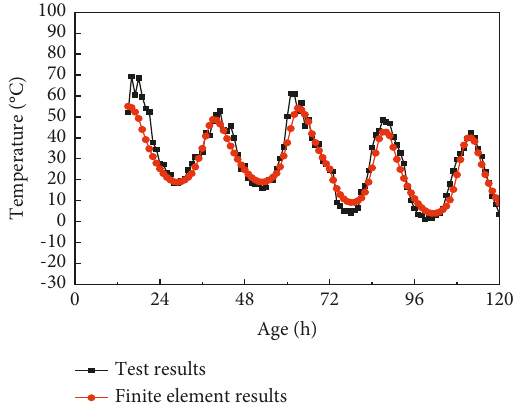
Figure 9: The temperature comparison of the concrete.